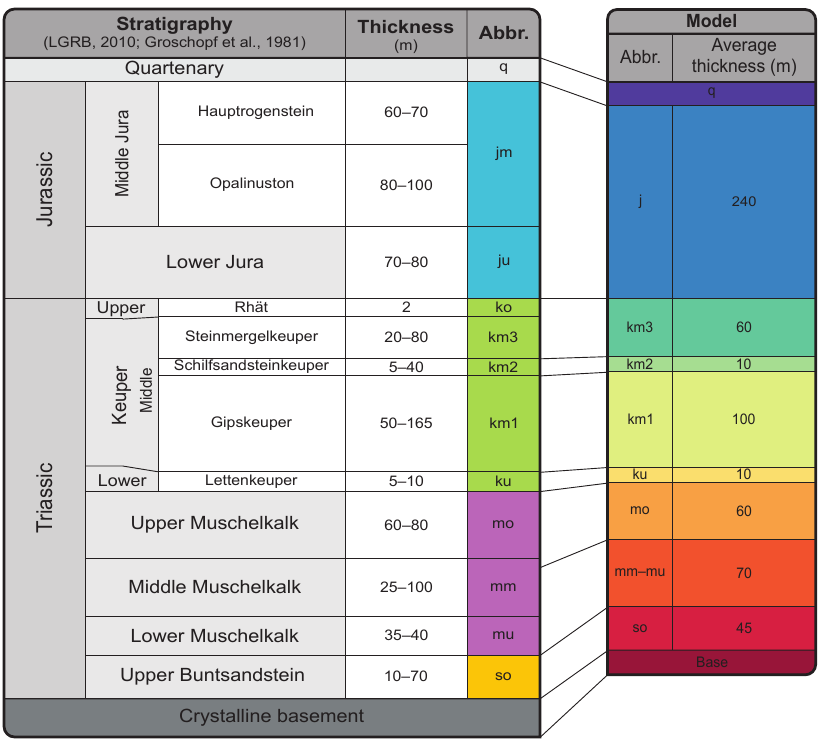
Figure 3. Stratigraphic overview of the study area and modeled geological units with average thicknesses.